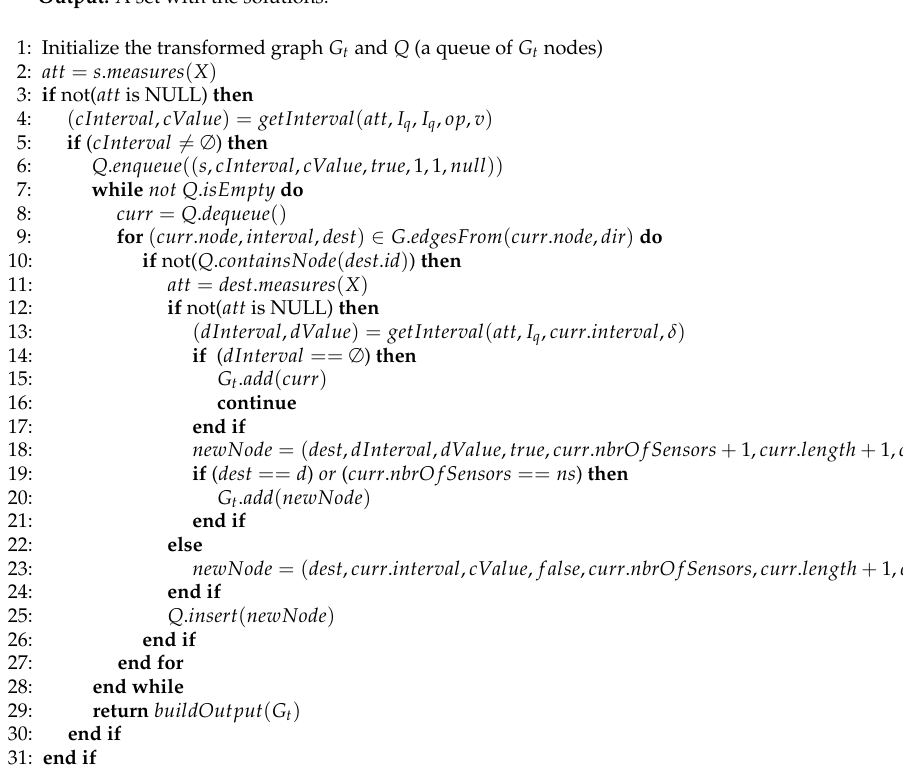
Algorithm 1 SensorFlowing : Computes the Flow